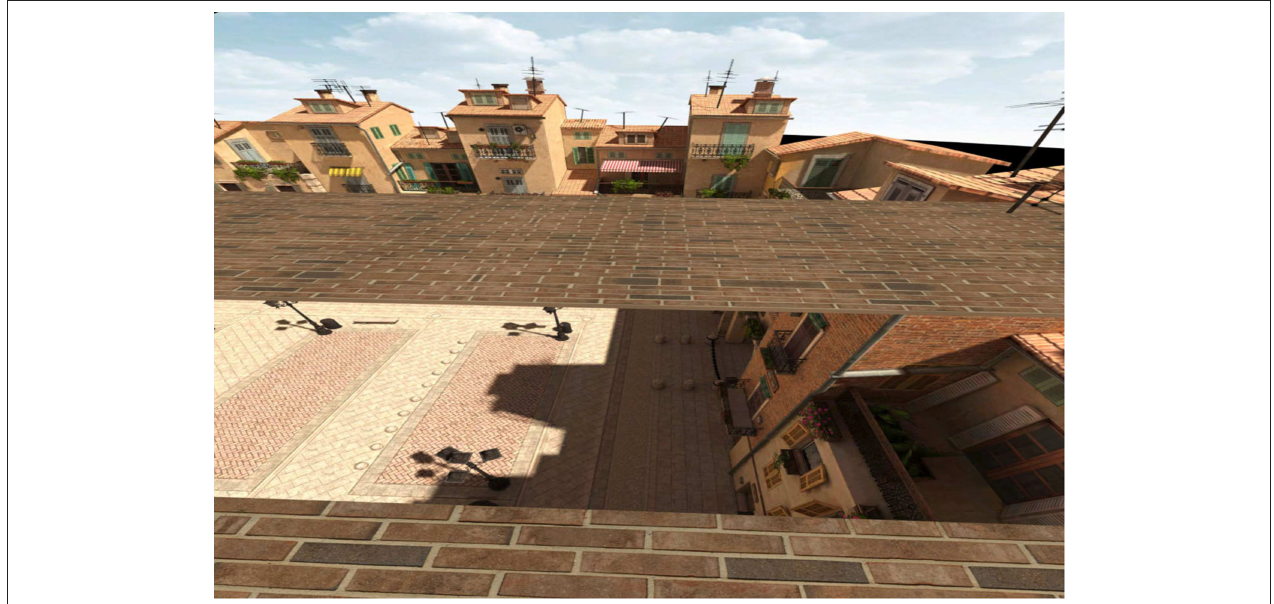
FIGURE 3 | An example of a gap at 15m height. The viewer stood with their toes at the edge of the near brick surface and judged stepping so that their heel would touch the far brick surface.